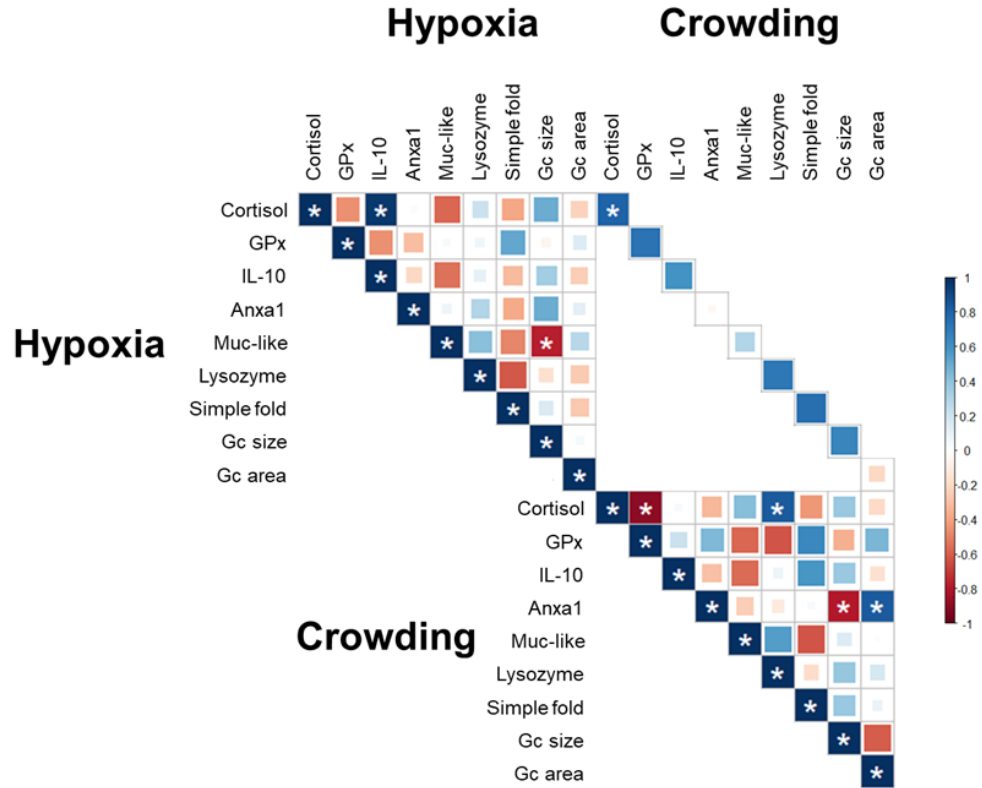
Figure 6 . Correlation coefficient between different phenotypic parameters. *: significant values ( p < 0.05). Degrees of freedom = 5.